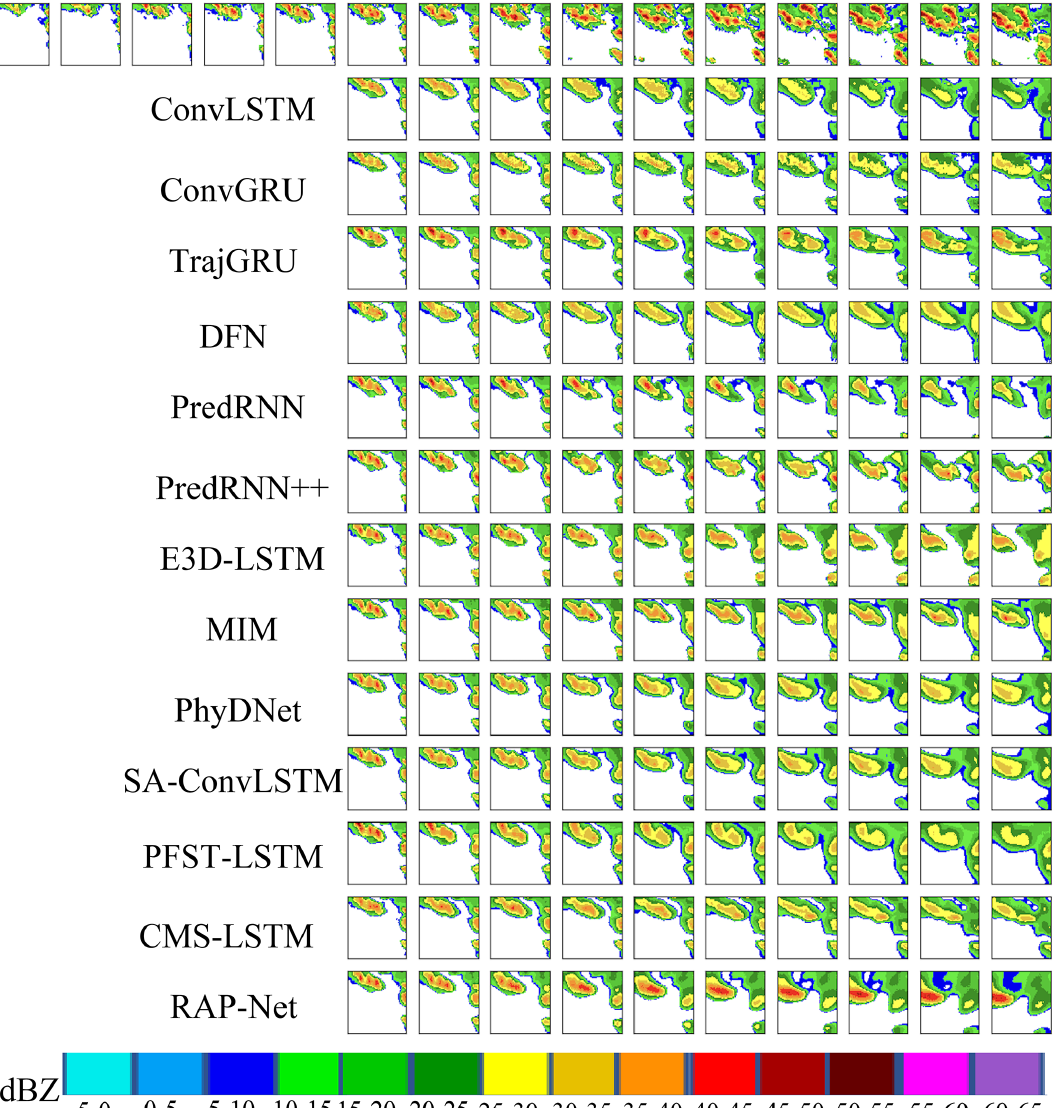
Figure 7. The first row is the reflectivity of the ground truth, and the remaining rows show the predicted reflectivity of various methods on an example from the RadarCIKM dataset (best viewed in